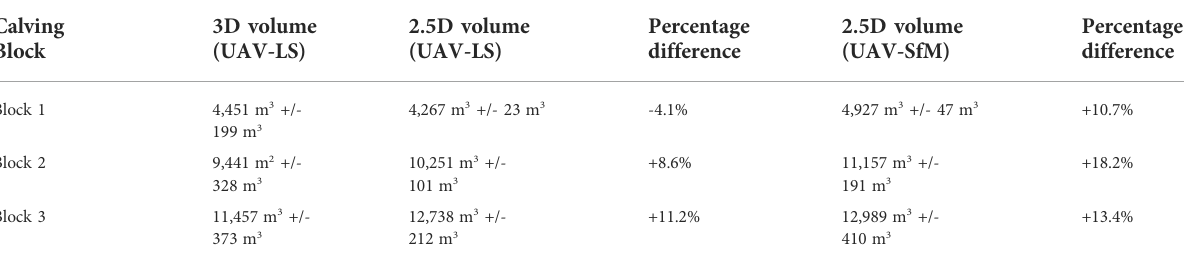
TABLE 4 Descriptive statistics showing the volume loss relating tothe threecalving blocks shown inFigure9.For each event, the volumes calculated using both 3D and 2.5D techniques on the UAV-LS and UAV-SfM datasets are presented. Percentage difference column refers to the difference between the 2.5D volumes for both UAV-LS and UAV-SfM methods to the UAV-LS 3D volume. The ± values are based off the NMAD values for the weekly change detection in Figure 3 and Figure 6. Above water line volume (m 3 )